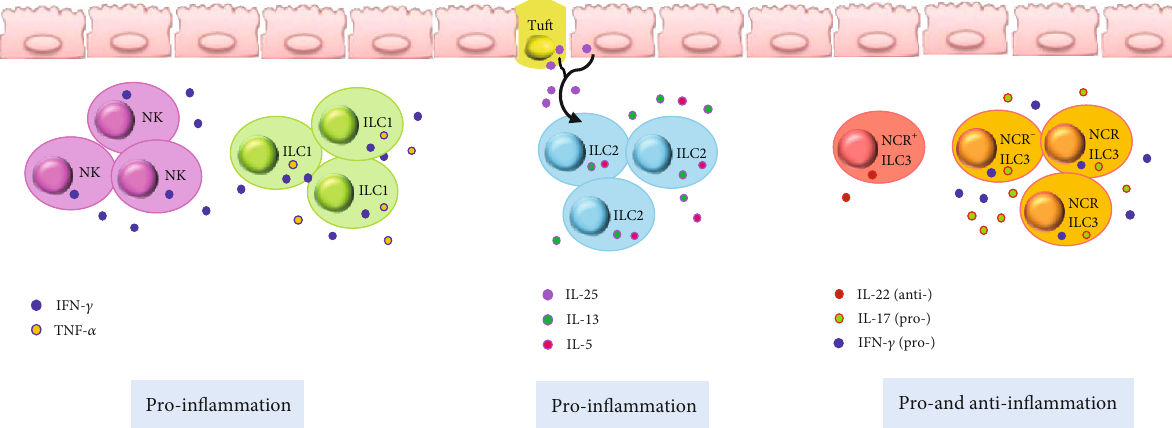
Figure 2: Potential pro- and anti-in fl ammatory roles of ILCs in intestinal chronic in fl ammation. NK cells and ILC1s are increased in the colonic lamina propria tissue of in fl ammatory bowel disease (IBD) patients. NK cells produce IFN- γ , whereas ILC1s produce IFN- γ and TNF- α . ILC2s play a pathogenic role by promoting IL-13- and IL-5-driven in fl ammation in a mouse model of colitis, which is ameliorated by blocking IL-25. IL22 + NCR + ILC3s are decreased dramatically and NCR − ILC3s are increased under chronic in fl ammation conditions. The NCR − ILC3 subset can contribute to intestinal chronic in fl ammation through the production of IL-17A and IFN- γ